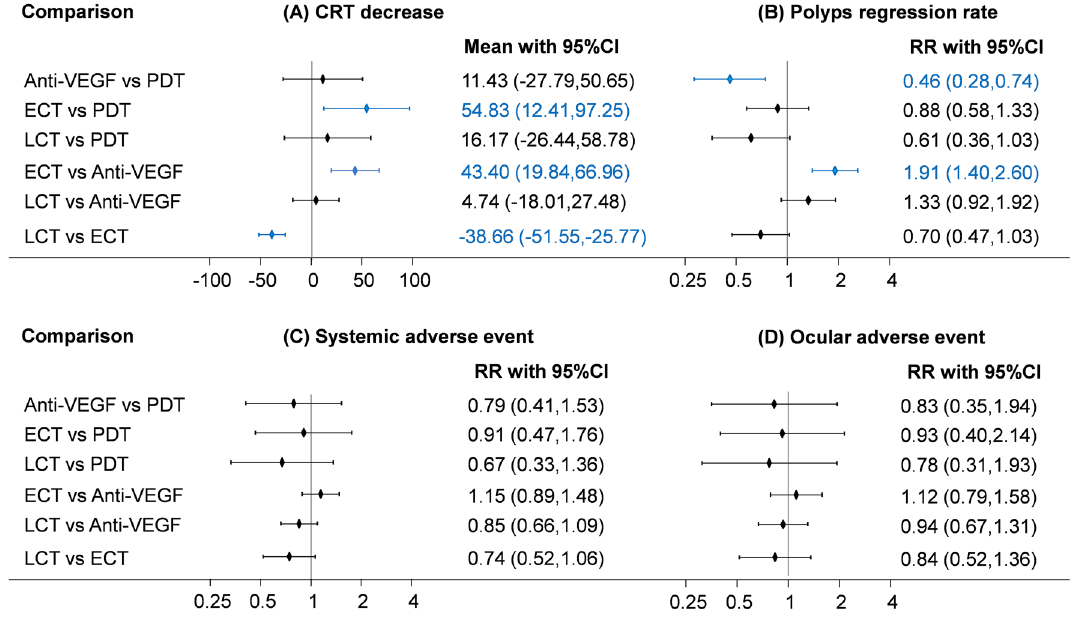
Figure 2. Forest plot of main findings.